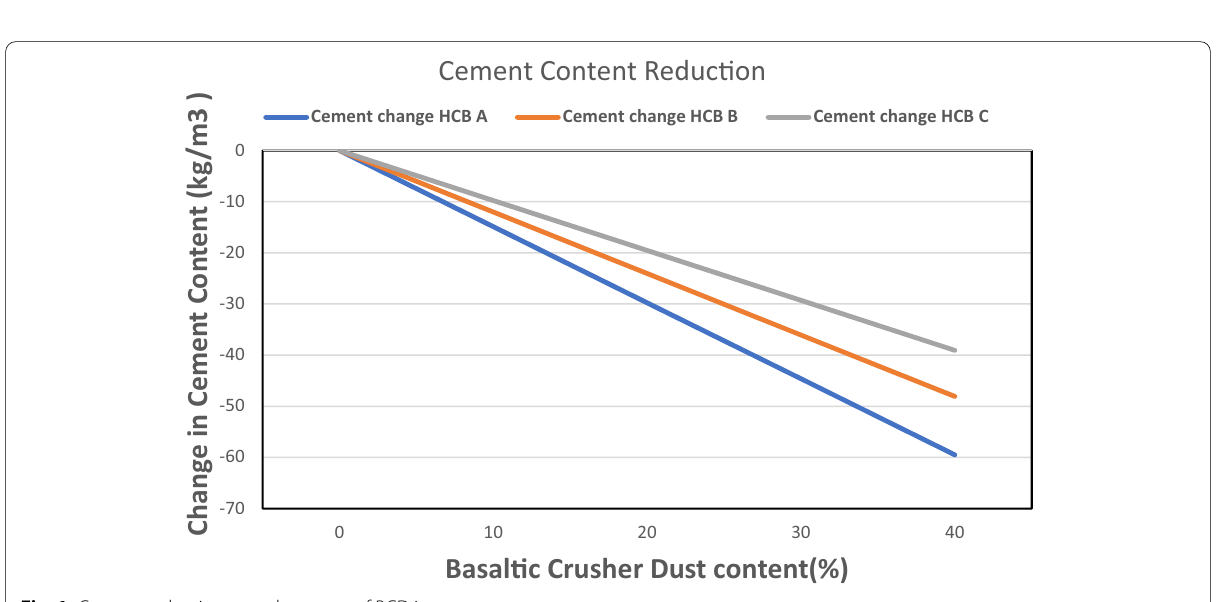
Fig. 1 Cement reduction as replacement of BCD in